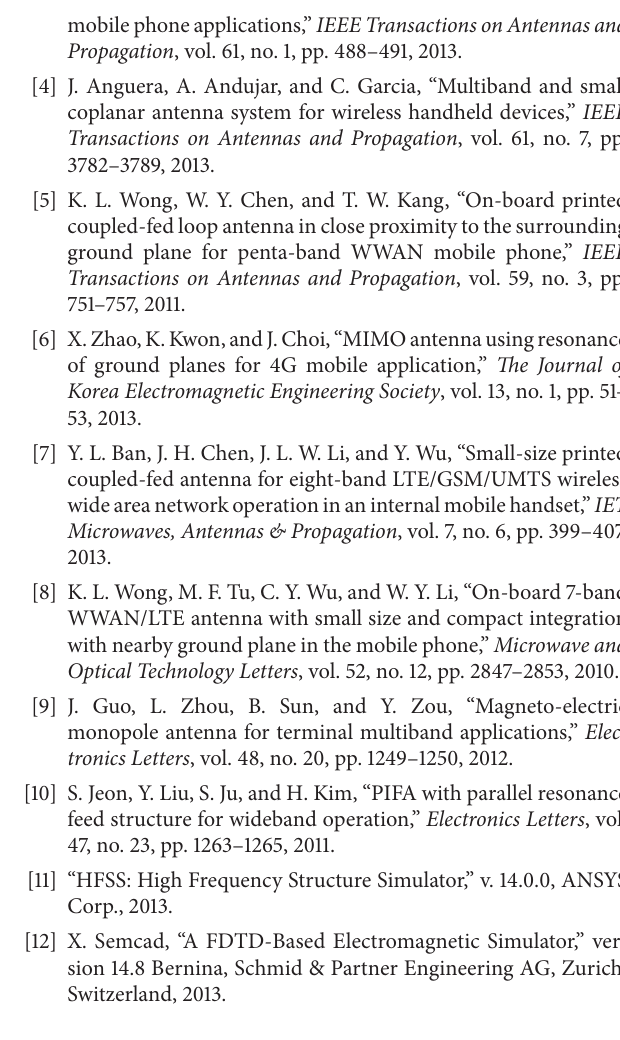
Table 4: Measured 1-g and 10-g SAR values for the fabricated antenna with head phantom (input power: 0.1W). Frequency (MHz)